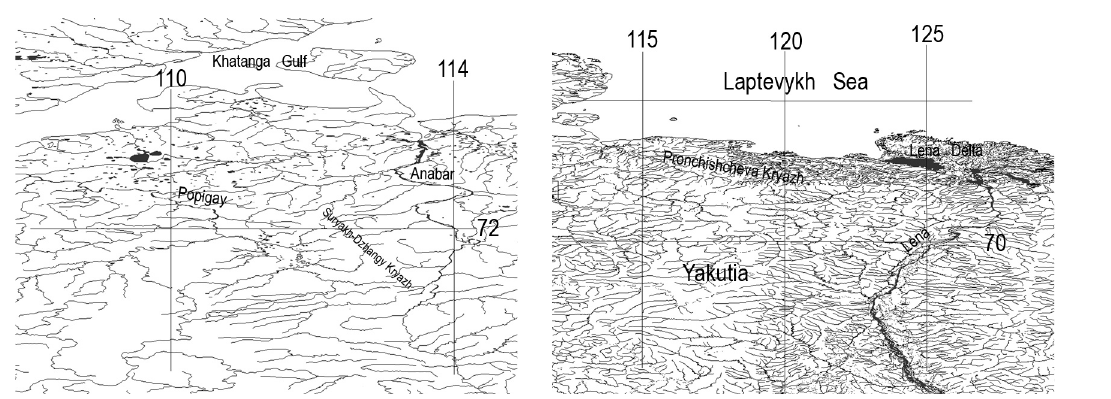
Fig. 14. Map of Suryakh-Dzhangy Kryazh Mountains calving grounds.